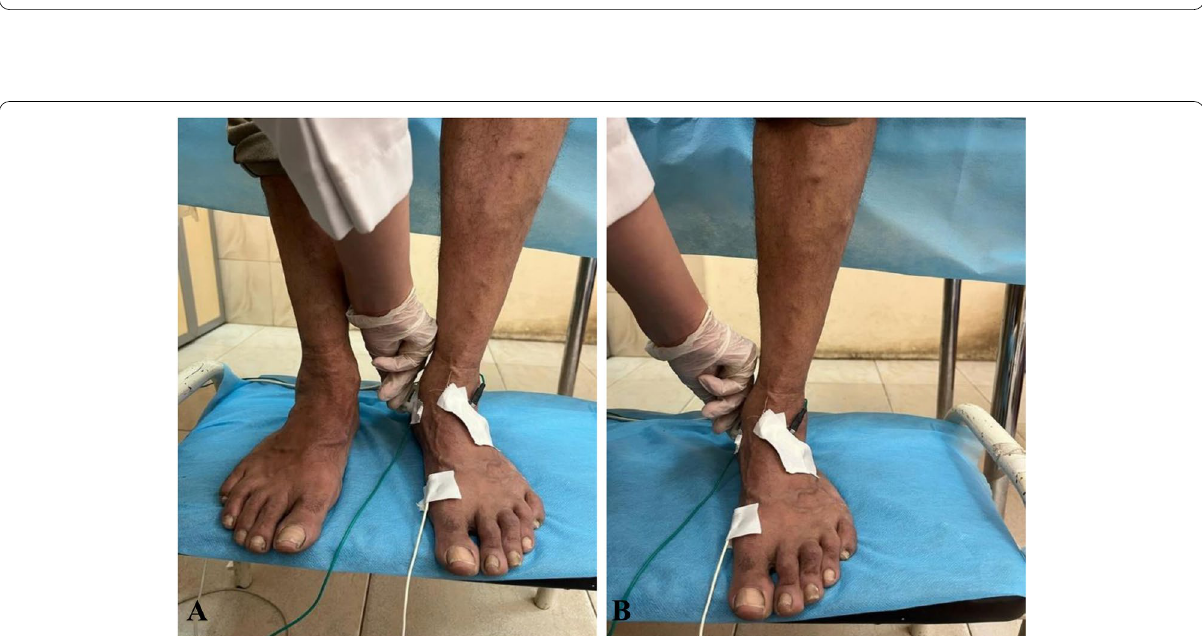
Fig. 2 NCSs of Medial plantar (MP) nerve using novel test during ( A ) double stance (DS) using DST, and ( B ) single stance (SS) using